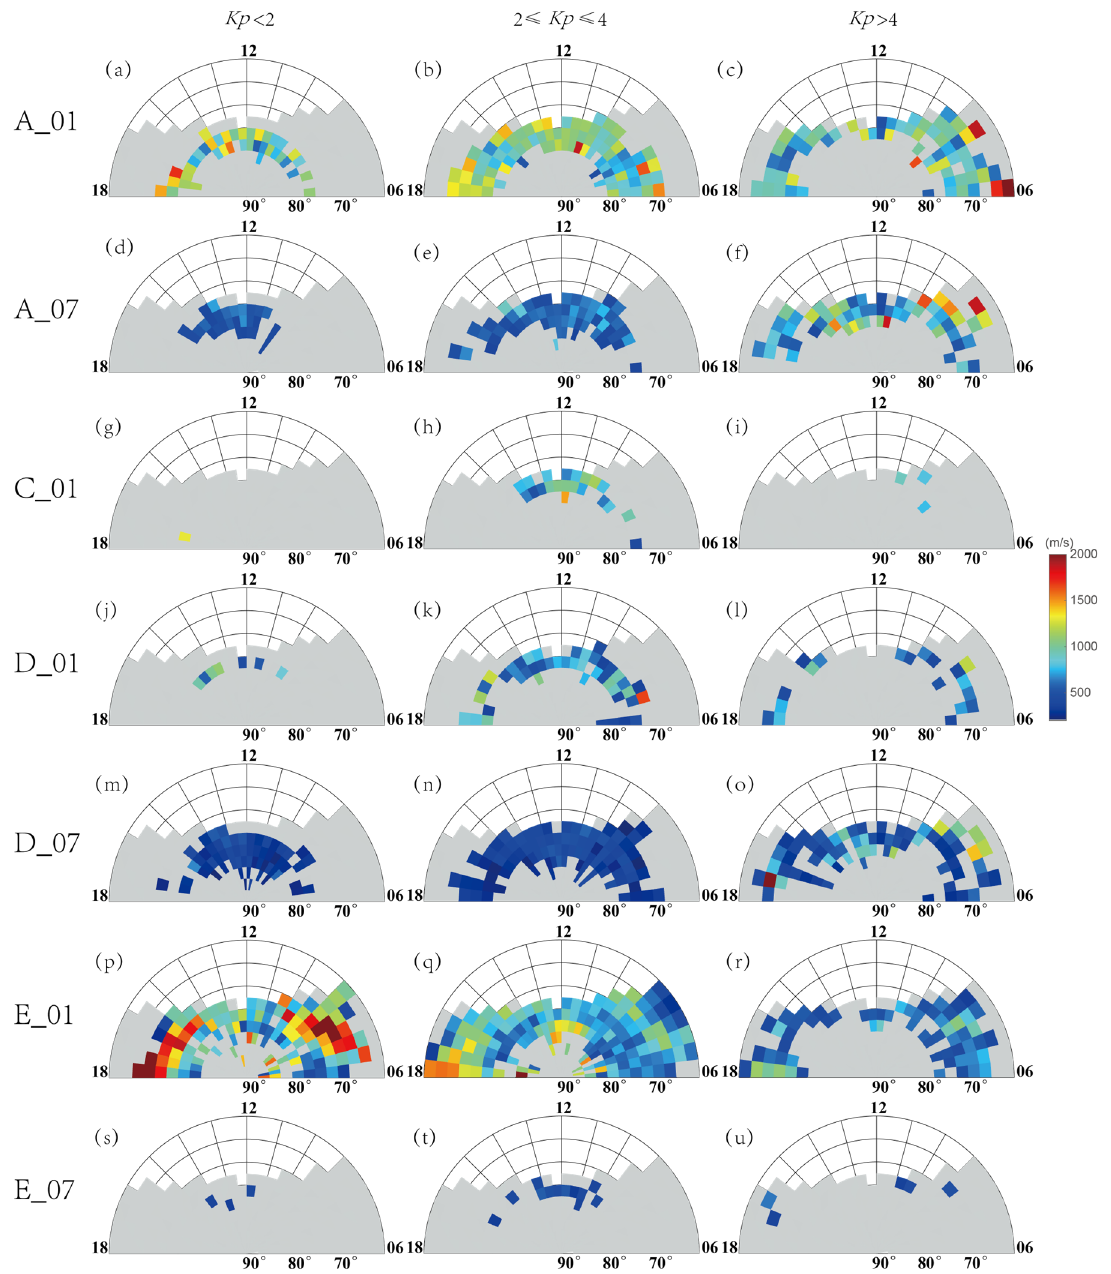
Figure 9. Temporal–spatial distribution of the average velocities of different types of ion upflows under different geomagnetic activities. ( a – f ) average velocities of type A in January/July, ( g – i ) average velocities of type C in January, ( j – o ) average velocities of type D in January/July, ( p – u ) average velocities of type E in January/July.